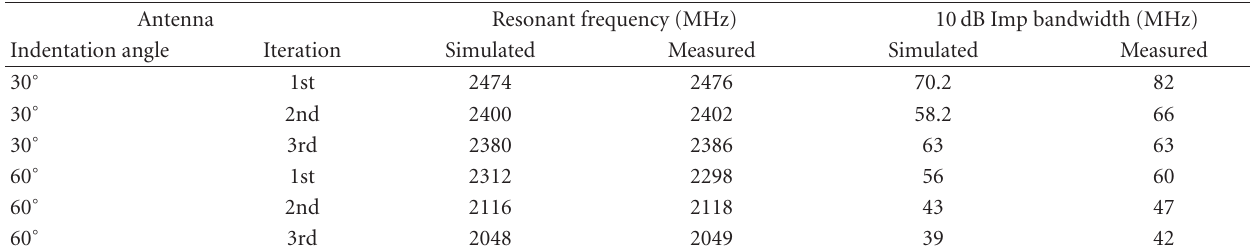
Table 3: Comparison of simulated and measured results.